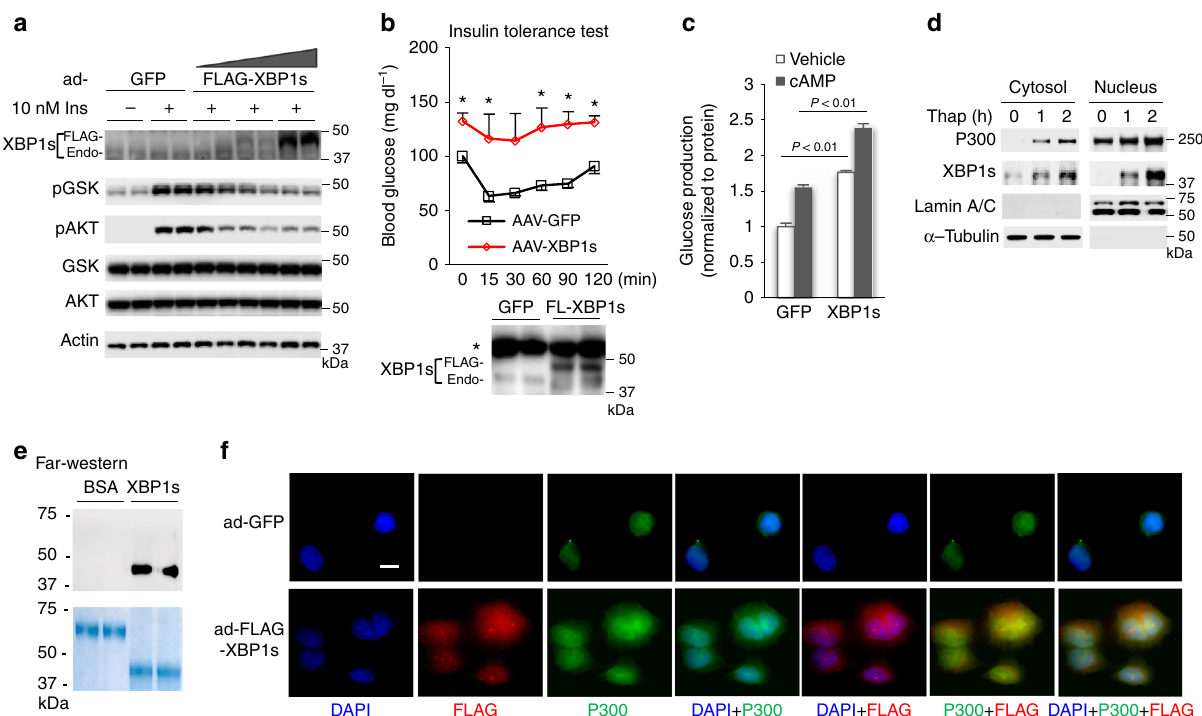
Fig. 4 Overexpression of XBP1s impairs insulin signaling and increases the cytoplasmic localization of P300. a Forty-eight hours after the addition of adenoviral-GFP and-FLAG-tagged XBP1s, Hepa1-6 cells were subjected to 4 h serum starvation and treated with insulin (10 nM) for 10 min. b WT mice were injected with AAV-TBG-GFP and AAV-TBG-XBP1s (3 × 10 11 GC/mouse). An insulin tolerance test (3 h fast, 0.5 unit per kg) was conducted 10 days after viral injection ( n = 4 – 5). Bottom, expression levels of XBP1s in the liver. Endo, endogenous. *, nonspeci fi c. The indicated signi fi cance is the result of a paired sample t -test between mice injected with AAV-TBG-GFP and AAV-TBG-XBP1s. c Primary hepatocytes were isolated from mice injected with AAV-TBG-GFP and AAV-TBG-XBP1s and subjected to a glucose production assay (0.2 mM cAMP, 4 h) ( n = 3). d Hepa1-6 cells were treated with 400 nM thapsigargin for indicated time, cytosol and nuclear extracts were prepared. e Same amounts of bovine serum albumin and puri fi ed FLAG-tagged XBP1s protein were subjected to SDS – polyacrylamide gel electrophoresis (staining with Colloidal blue, lower ) or transferred to membrane, then incubated with human P300 protein (1 µ g) for 16 h, washed, followed by incubation with antibody against P300 ( upper ). f 48 h after the addition of adenoviral -GFP and -FLAG-tagged XBP1s, Hepa1-6 cells were subjected to immuno fl uorescence staining. Scale bar, 10 µ m. Data are presented as mean ±